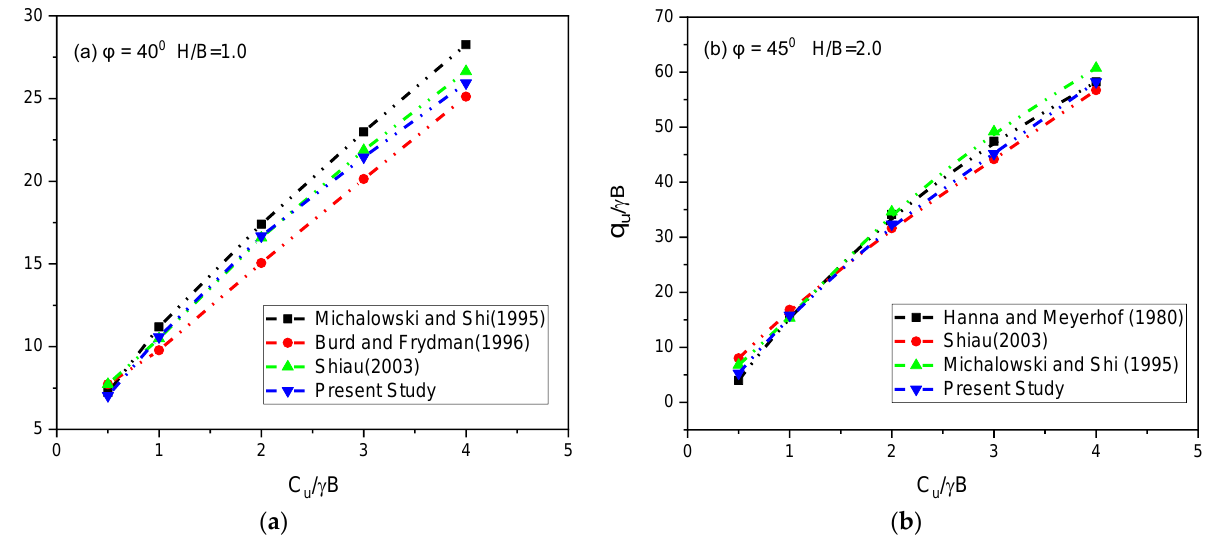
Figure 3. Dimensionless bearing capacity, qu/γB , for different values of Cu/γB from FLAC 2D compared with the results found in the literature: ( a ) φ = 40°, H/B =1; ( b ) φ = 45°, H/B =2.